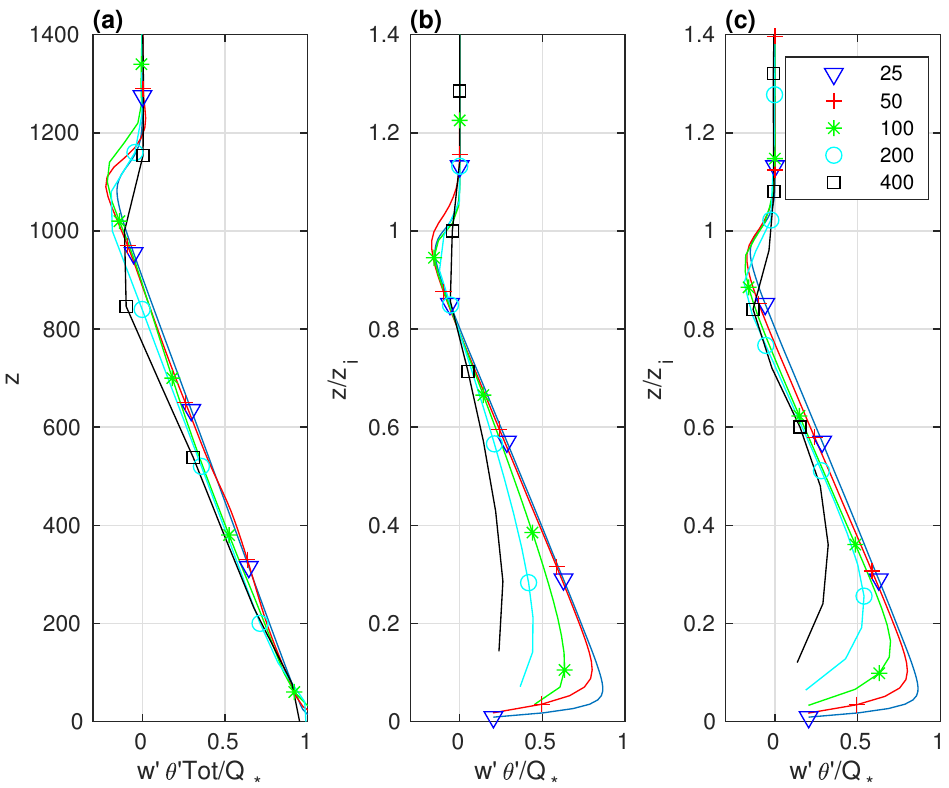
Figure 6. Domain-averaged profiles from CBL2 runs ( a ) for total temperature flux at different native grid spacings and resolved temperature flux ( b ) for a 25 m grid length and coarse grained to other grids and ( c ) at different native grid spacings. Fluxes are normalized by the surface value ( Q ∗ ) and shown as a function of the normalized height. Each line is for a different coarse graining scale ( b ) or for a simulation with a different grid length ( c ), the values in m being indicated in the